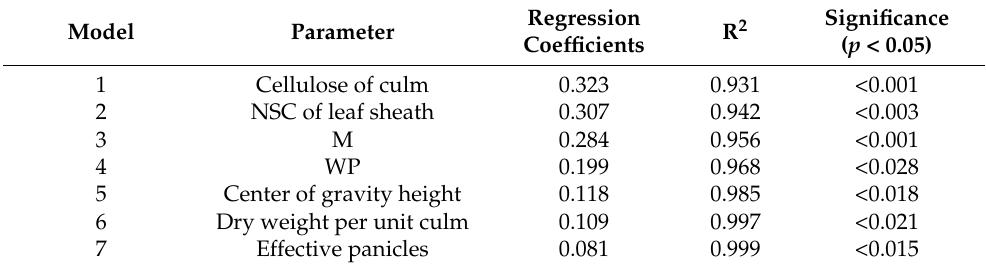
Table 13. Selected traits in stepwise regression